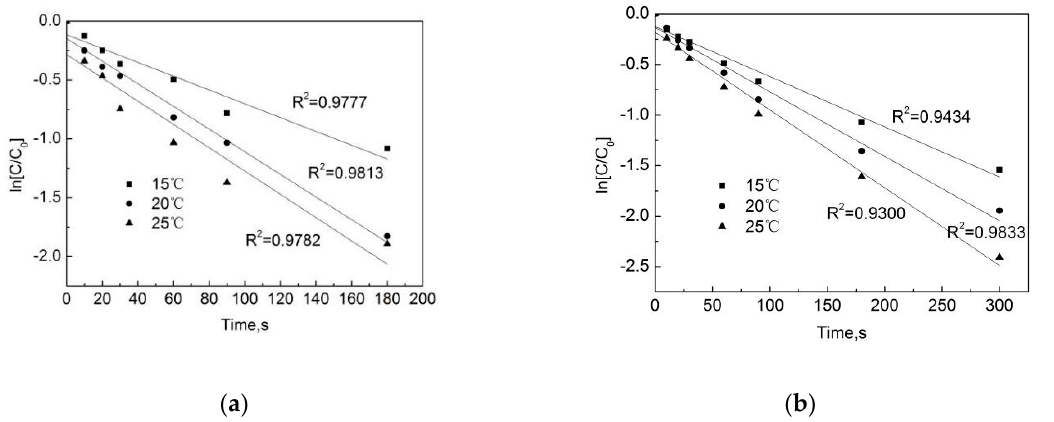
Figure 9. Degradation of OFL under different temperatures in ( a ) the water distribution system, and in ( b ) the deionized water.